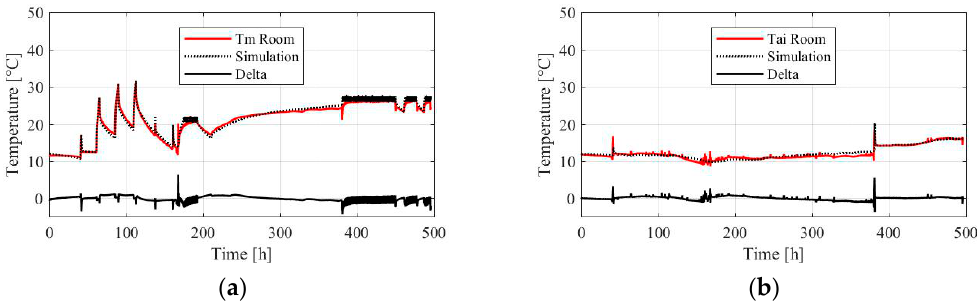
Figure 5. Room air temperatures measured, simulated and difference for ( a ) CR and ( b ) MR.